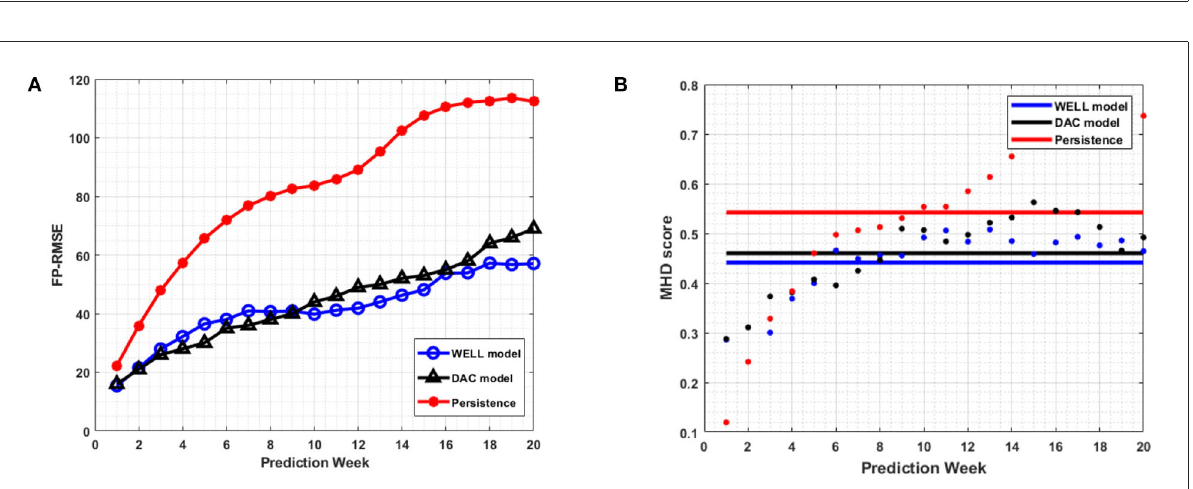
FIGURE10 The average FP RMSE (A) and the average MHD score (B) per week for all 20-week prediction sliding windows over March 2008 to December 2009 period. The horizontal axis is the number of weeks. The horizontal lines show the mean value of the MHD score for each model and